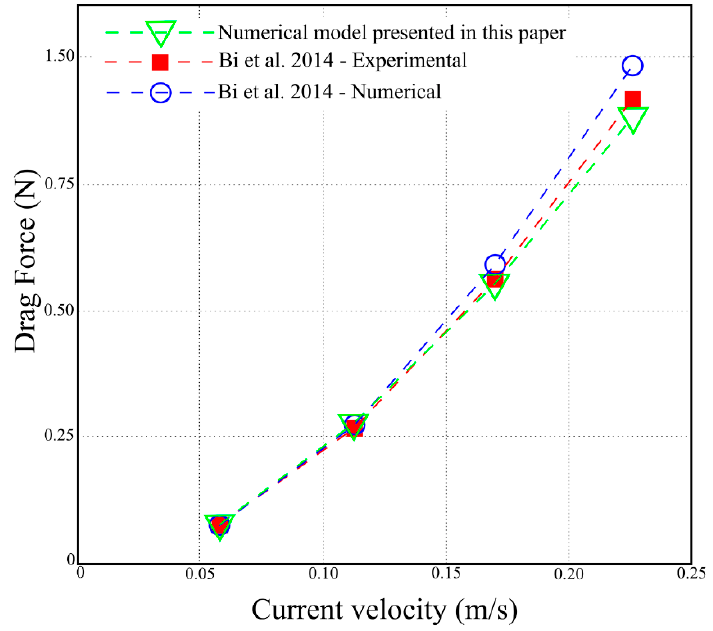
Figure 2. Comparison of the drag forces measured experimentally (red dashed line and red squares) and evaluated numerically (blue lines and blue circles) by [29], and the drag forces evaluated numerically with the proposed method (green line and triangles). Modified figure from [29].